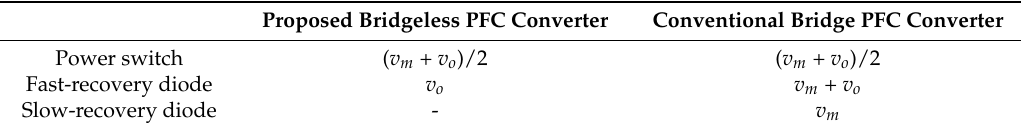
Table 1. The voltage stress of semiconductors.